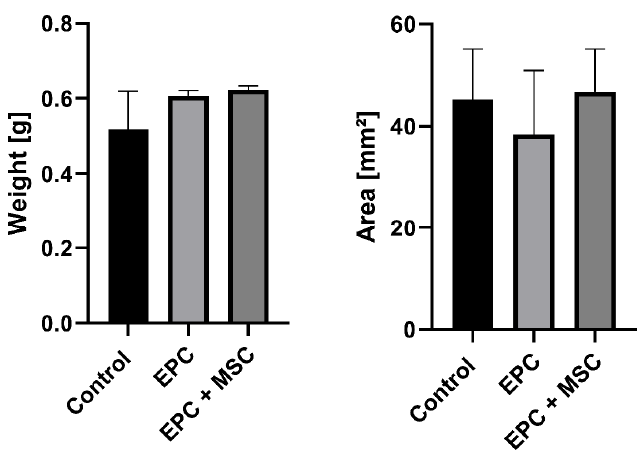
Figure 4. Construct weight and size. The experimental groups displayed no statistically significant differences considering the construct weight ( A ) and size ( B ). The cell-free group is indicated as “control”.